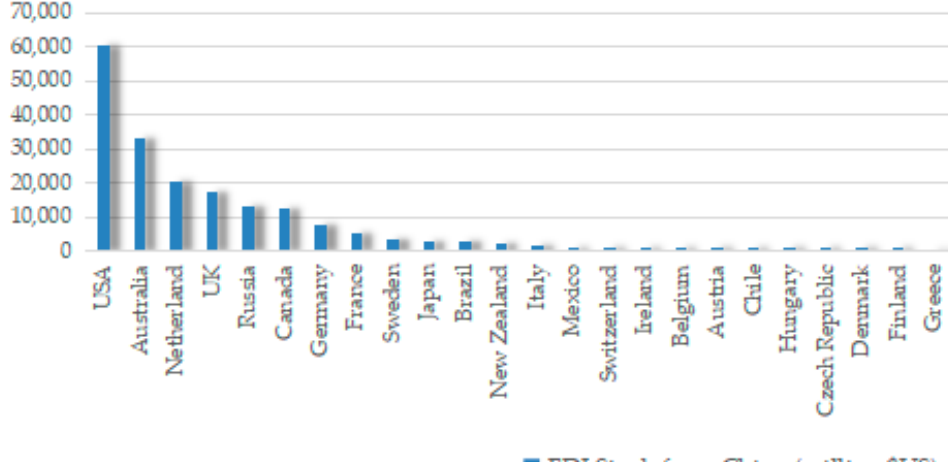
Figure 4. Chinese outward FDI stock to OECD countries in 2016.